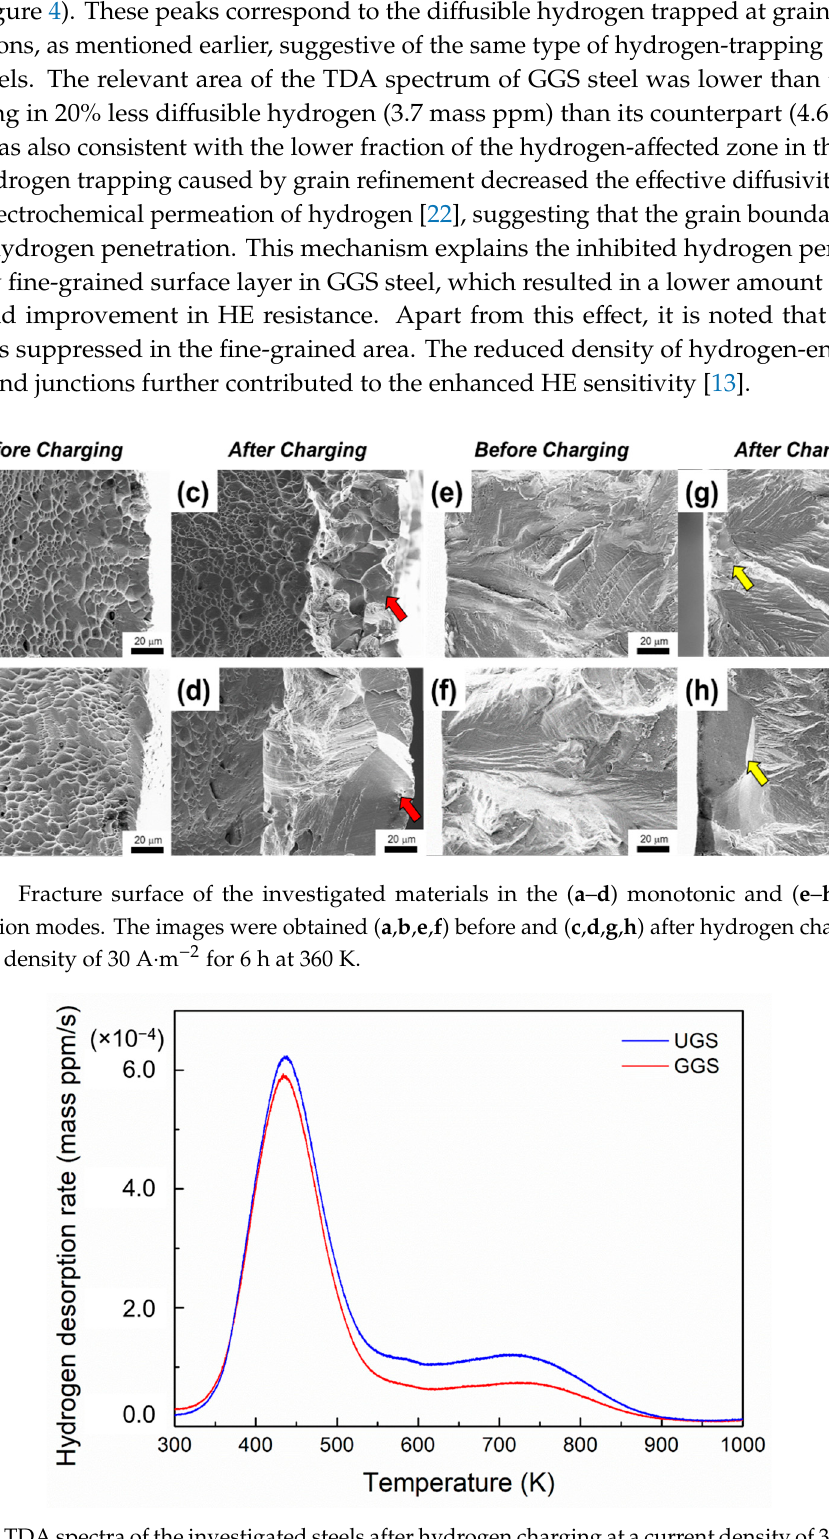
Figure 4. TDA spectra of the investigated steels after hydrogen charging at a current density of 30 A · m − 2 for 6 h at 360 K.